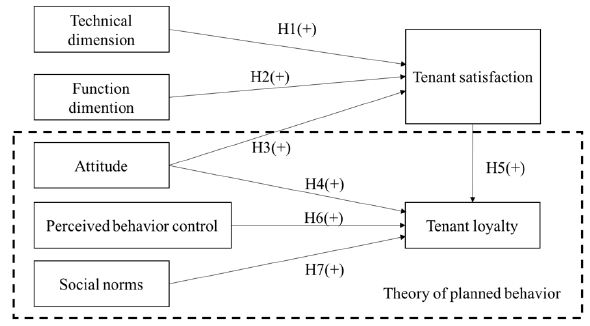
Figure 1. Research framework